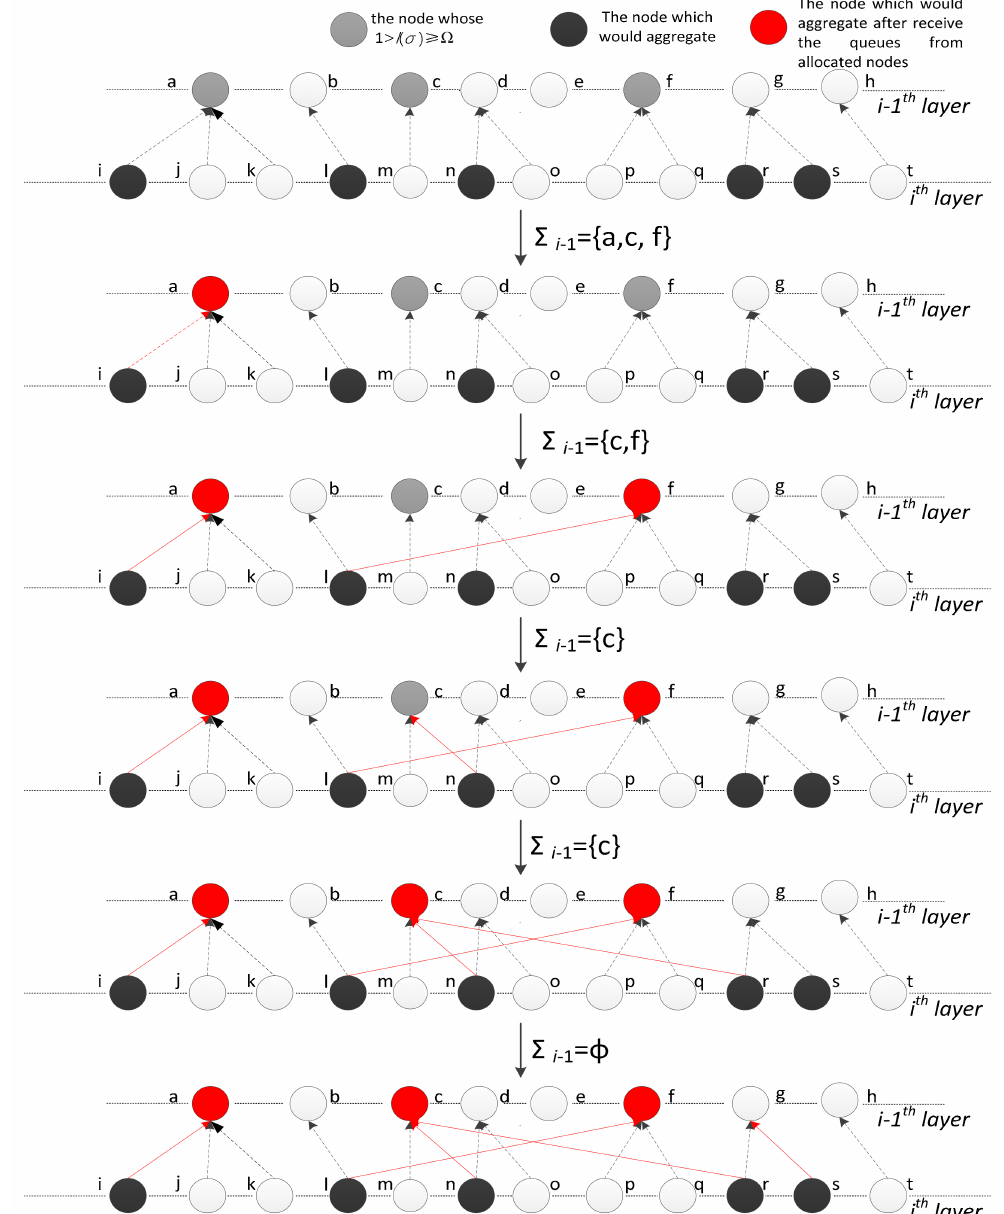
Figure 5. Demonstration diagram of the